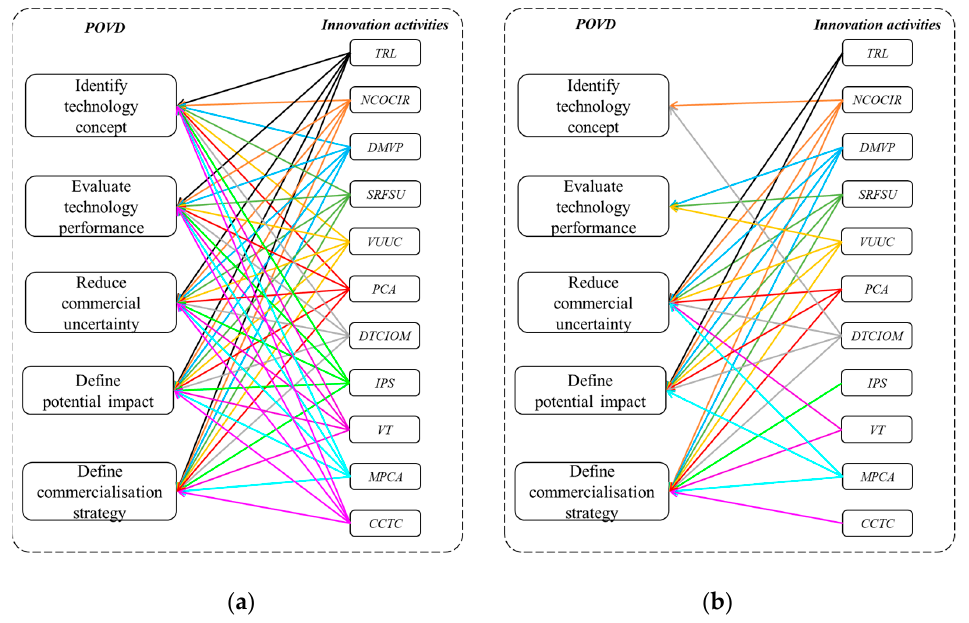
Figure 9. Comparison between mental model A ( a ) and E ( b ). Acronyms can be found in Section 2.1.